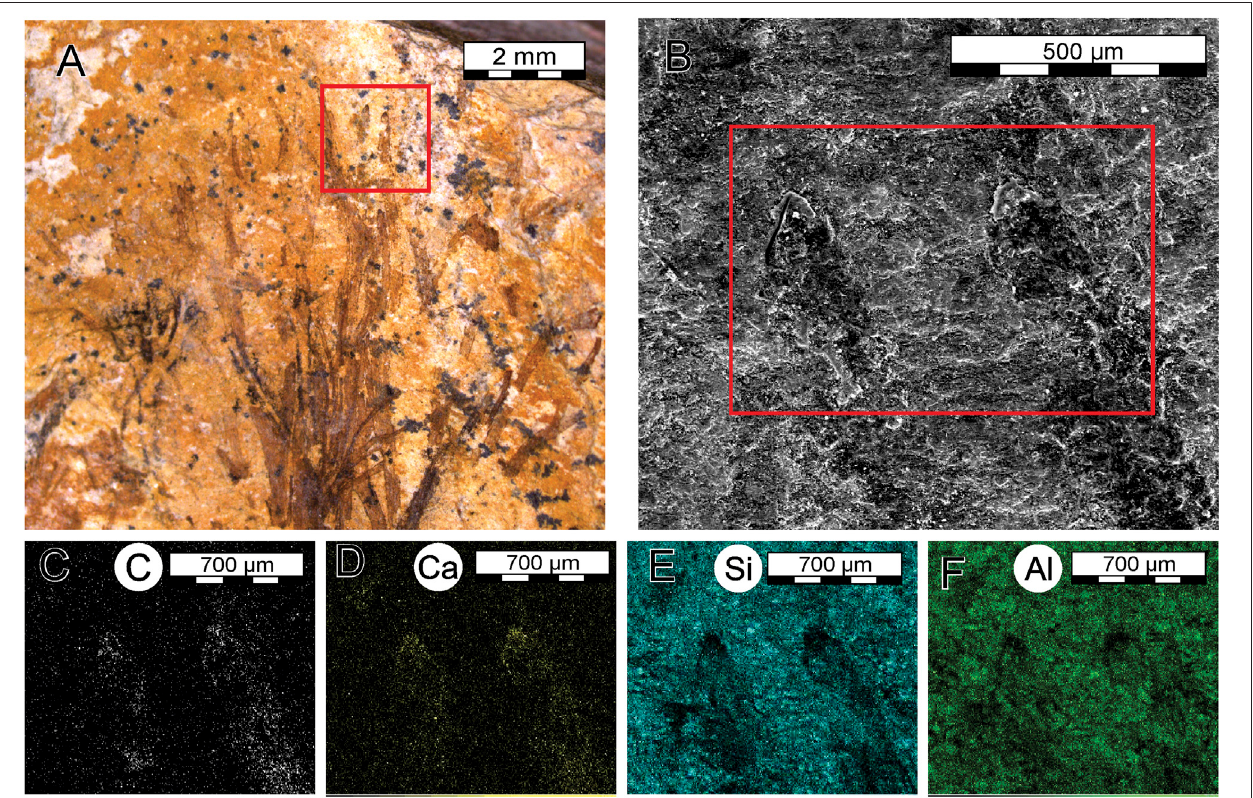
FIGURE6| AnalysisofSEMand EDSof L.hidria . (A) Thecompletefossil,wheretheredsquarehighlightsthezoommadeinimage (B) . (B) AnalysisofSEM,where theredrectanglehighlightsthezoommadeintheotherimages. (C) Concentrationofcarbon. (D) Concentrationofcalcium. (E) Concentration ofsilica. (F) Concentration of